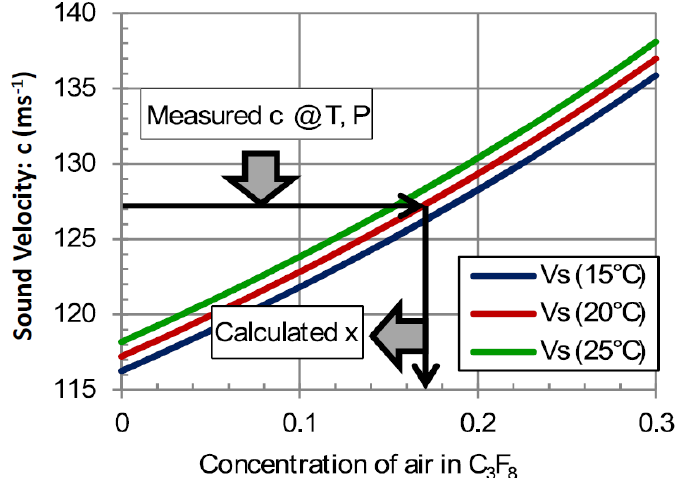
Figure 10. The sound velocity is calculated according to the formalism of Equations (1)–(6) for C F /air mixtures in the molar concentration range (0%–30% air) at 1 bar 3 8 tube operating temperatures